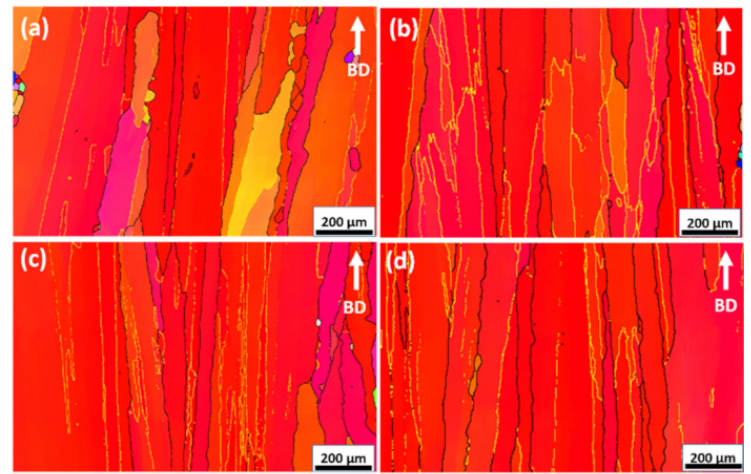
Figure 6. EBSD–IPF maps of post-heat-treated specimens along the building direction: ( a ) DA, ( b ) STA, ( c ) HSA, ( d ) HA. The low-angle grain boundaries (LABs) (2 ◦ ≤ θ < 10 ◦ ) and high-angle grain boundaries (HABs) (10 ◦ ≤ θ ) are indicated by yellow and black lines, respectively.